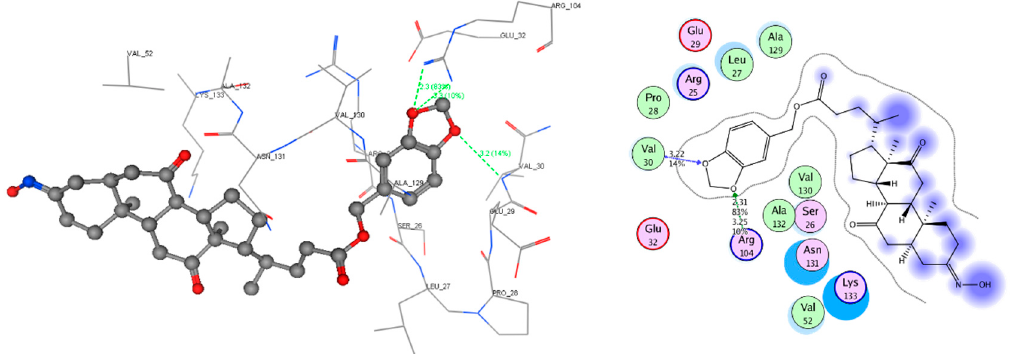
Figure 7. Theoretical Binding mode of compound 2b-1 in HSPG (PDB: 3sh5) in 3D and 2D.